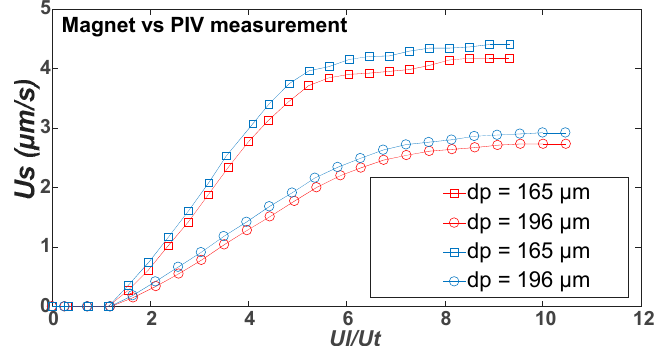
Figure 6. Particle circulating speed as a function of normalised velocity ( U l / U t ) for both the PIV technique (blue) and the accumulation method (red), inside 15% solid inventory bed.